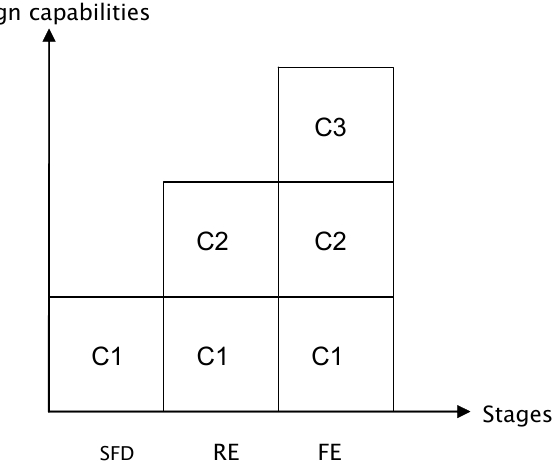
Figure 2. Three-stage Process of Accumulating Product Development